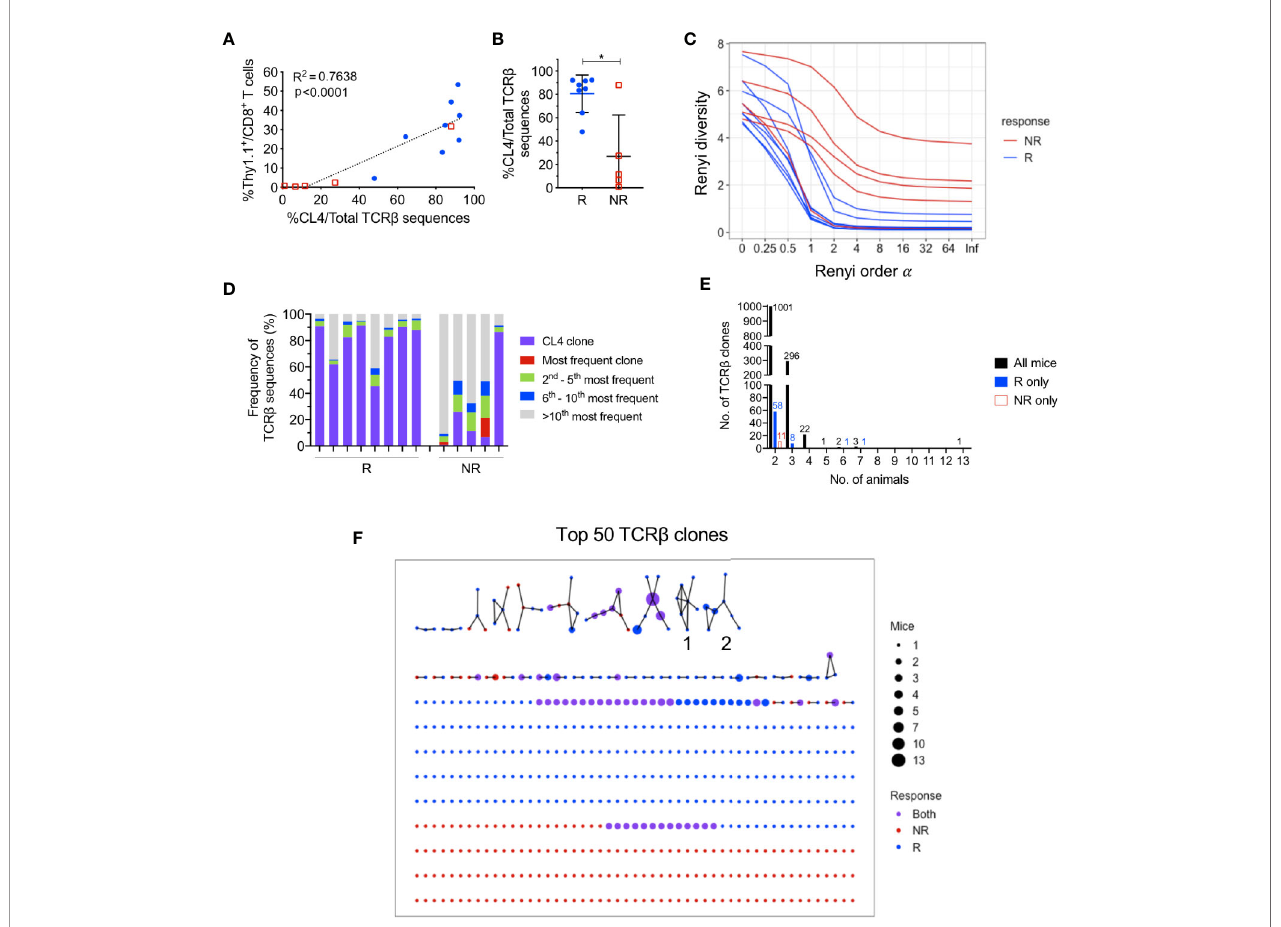
FIGURE 3 | CL4 transgenic TCR b clone dominated post-treatment CD8 + TIL TCR b repertoire in responding animals. (A) Linear regression analysis between the CL4 TCR b clone frequency in TCR b sequencing and the frequency of CD8 + Thy1.1 + T cells analyzed in fl ow cytometry. (B) Dot plot representing the CL4 TCR b clone frequencies in responders (R; blue) and non-responders (NR; red). (C) Graph of Renyi diversity pro fi les for each TCR b repertoire. The scale of Renyi order a corresponds to calculated diversity metrics. a = 0 indicates the richness of the repertoire (number of unique TCR b clones). Shannon ’ s diversity index corresponds to a = 1. Each line represents the Renyi entropy of one animal, and a steeper gradient between a = 0 and 1 represents a less diverse repertoire. (D) Bar graph displaying proportions of the 10 most frequent TCR b clones in responders and non-responders. Each bar represents the TCR b repertoire of one animal. CL4 clone (purple) is the most frequent clone in 11/13 animals. (E) Bar graphs representing the number of shared TCR b clones between 2 or more animals. Shared clones are separated into overlap within only responders (blue), only non-responders (red), or all mice regardless of outcome (black). (F) Network analysis of the top 50 most abundant TCR b clones for each animal. Each node represents a unique CDR3 TCR b sequence (TCR b clone) and each edge de fi nes a single amino acid difference (levenshtein distance of 1). Size of each node represents the number of mice that have the TCR b clone in their repertoire and nodes are colored by presence of TCR b clone in only responders (blue), only non-responders (red) or both groups (purple). Data is shown as mean ± SD where appropriate; R (n = 8) and NR (n = 5) were sampled from three independent experiments; Mann-Whitney U tests; *P ≤